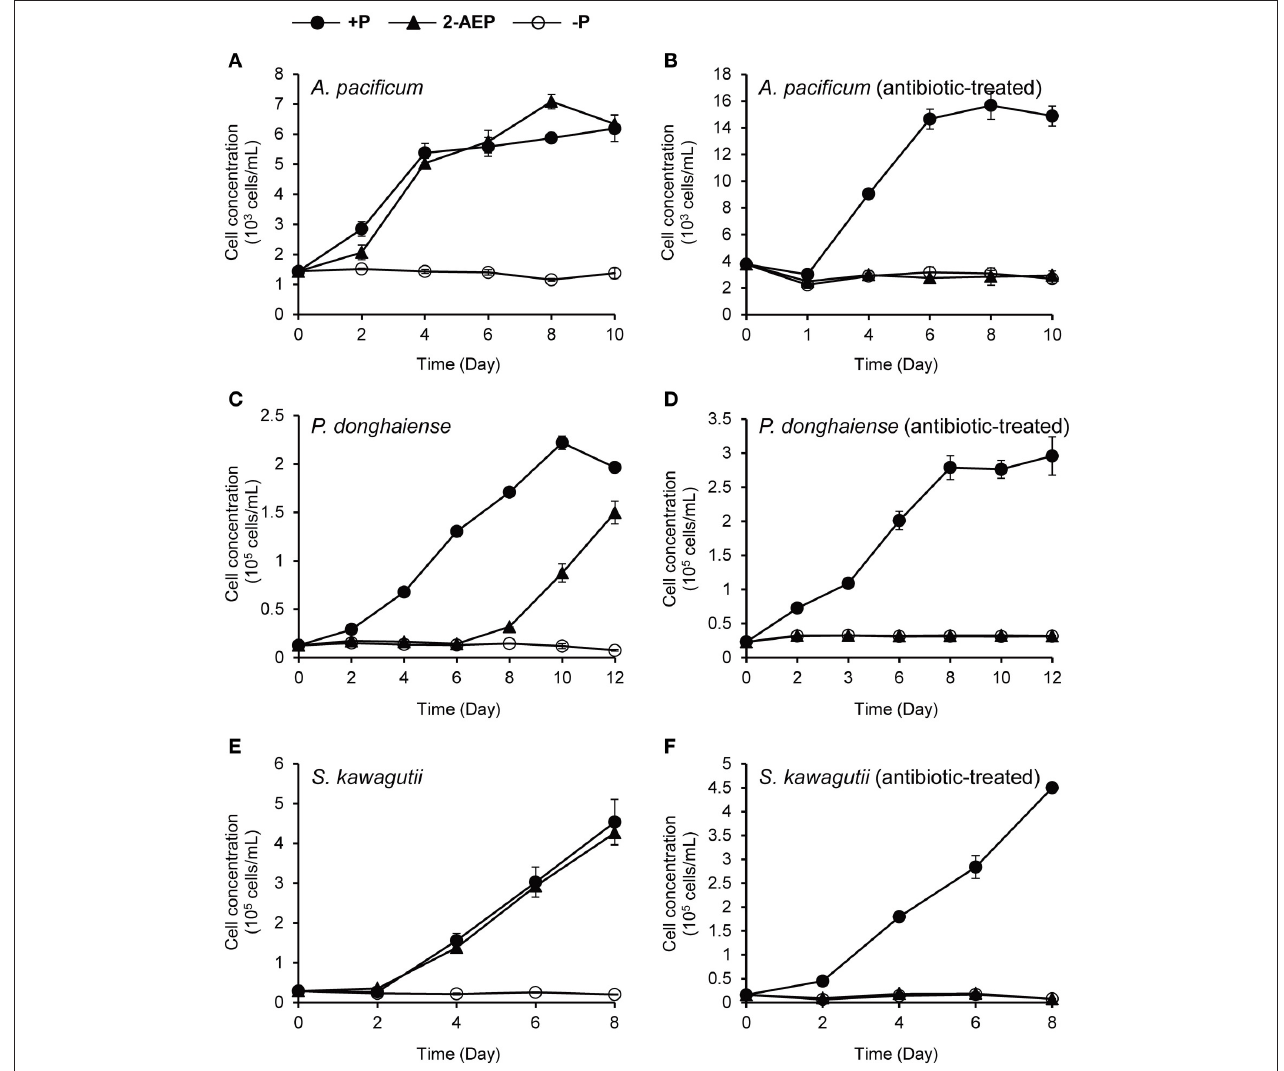
FIGURE 3 | Comparison of the growth curves of different dinoflagellates under different P conditions with vs. without antibiotic treatment. (A,B) Growth curves of A. pacificum cultures without and with antibiotic treatment. (C,D) Growth curves of P. donghaiense cultures without and with antibiotic treatment. (E,F) Growth curves of S. kawagutii cultures without and with antibiotic treatment. Solid circles, P-replete condition; solid triangles, P-depleted condition amended with 2-AEP; open circles, P-depleted